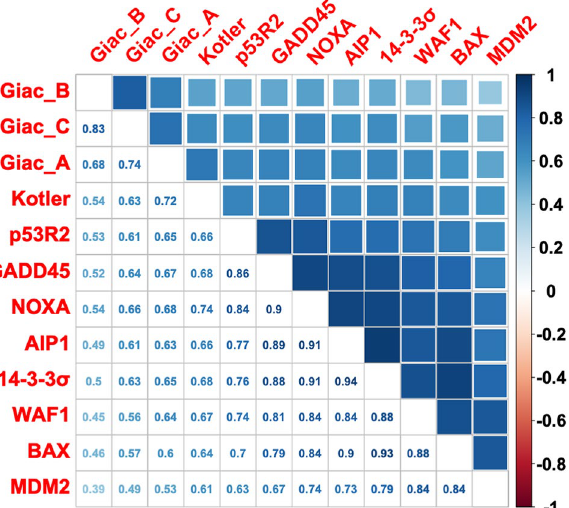
Figure 2. Correlation matrix for the three large-scale (12 read-outs) analyses of TP53 activity. Correlation R values are shown on the left part of the panel. Positive correlations are displayed in blue and negative correlations in red. Color intensity and the size of the square are proportional to the correlation coefficients. On the right side of the correlogram, the legend color shows the correlation coefficients and the corresponding colors. All correlations are highly significant (p < 0.001) (see supplementary Fig. 3 for a detailed view of the